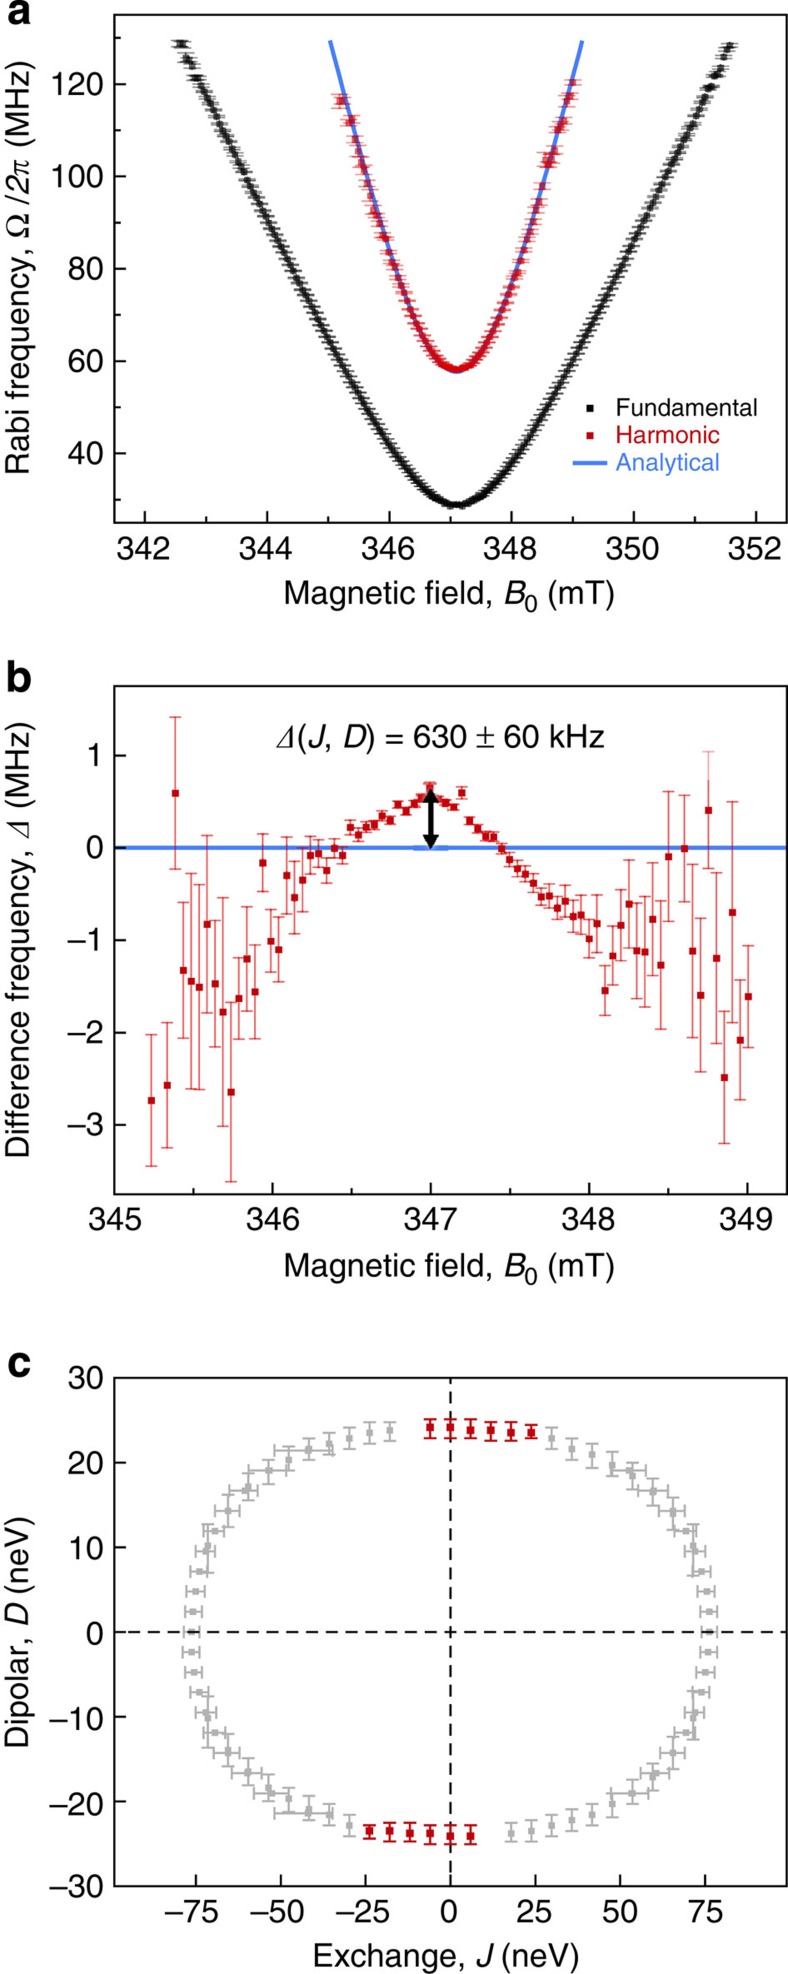
Deviations of measured spin-pair nutation harmonic frequency from the analytical description allowing for intrapair spin–spin interaction strength and intercharge separation to be quantified.(a) Frequency peaks for the detuning dependency of the fundamental (black) and harmonic (red) frequency components, plotted in Fig. 4c. The blue line shows the analytical solution for the Rabi frequency of a driven pair of weakly coupled spin-½ carriers (that is, for negligible zero-field splitting), given their measured Larmor separation and the known driving field B1 as parameters (see refs 29, 31, 32). (b) Difference, Δ, between measured and computed analytical harmonic frequency as a function of detuning. Since on-resonance, Δ, is a function of exchange J and dipolar coupling strength D, it allows for a direct determination of the intrapair spin–spin interaction strength. (c) Numerical simulation of intrapair spin–spin interaction strength. Plot of possible combinations of J and D that give rise to a shift of the harmonic oscillation frequency in agreement with the measured value Δ. By further simulating the detuning behaviour of all frequency components for each of these combinations and eliminating cases that strongly diverge from observation (grey), bounds are placed on the magnitudes of J and D (red), yielding |J|<30 neV and |D|=23.5±1.5 neV (see associated discussion in Supplementary Notes 5 and 6). Error bars in the simulation arise from the experimental uncertainty in Δ of 60 kHz. Vertical error bars denote simulations where J is fixed and D is varied, and vice versa for horizontal error bars.